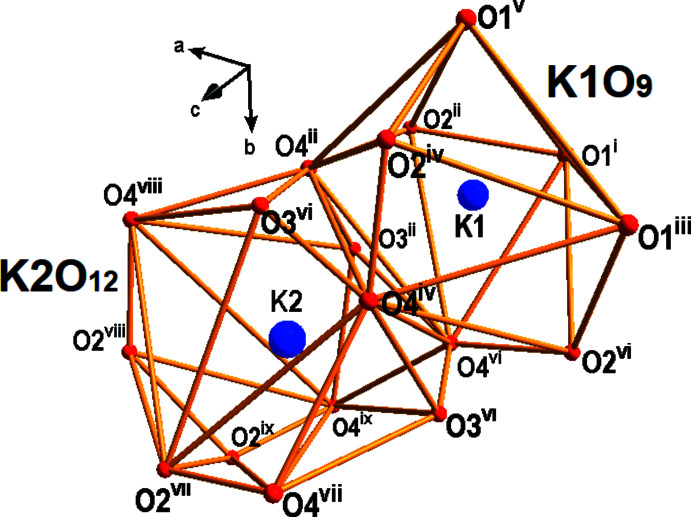
Coordination polyhedra [K1O9] and [K2O12] for (I). Displacement spheres are drawn at the 50% probability level. [Symmetry codes: (i) −x + 1, y + , −z + ; (ii) −x + , −y + 1, z + ; (iii) −z + , −x + 1, y + ; (iv) −y + 1, z + , −x + ; (v) y + , −z + , −x + 1; (vi) z + , −x + , −y + 1; (vii) −z + 1, x + , −y + ; (viii) −y + , −z + 1, x + ; (ix) x + , −y + , −z + 1].